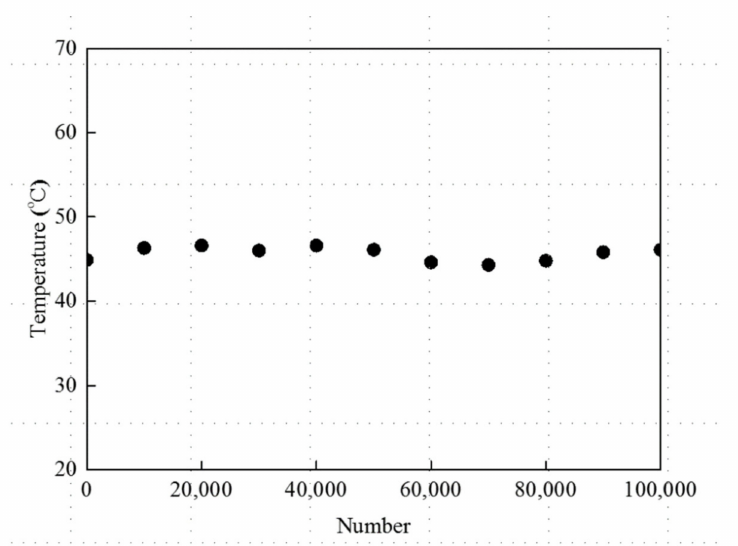
Figure 13. Heating temperature of the PTC-SHT at an applied voltage of 3V during stretching– contraction